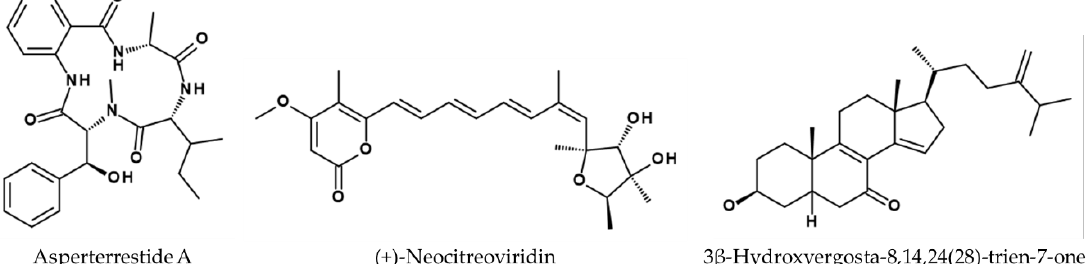
Figure 7. Structures of asperterrestide A [129], (+)-neocitreoviridin [131], and 3β -hydroxyergosta- 8,14,24(28)-trien-7-one [127].